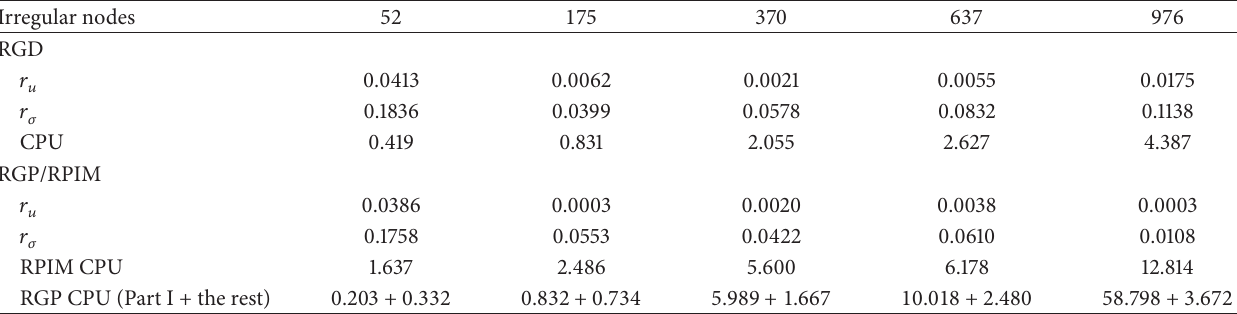
Table 5: Convergence study on irregular nodes for Example 5.2